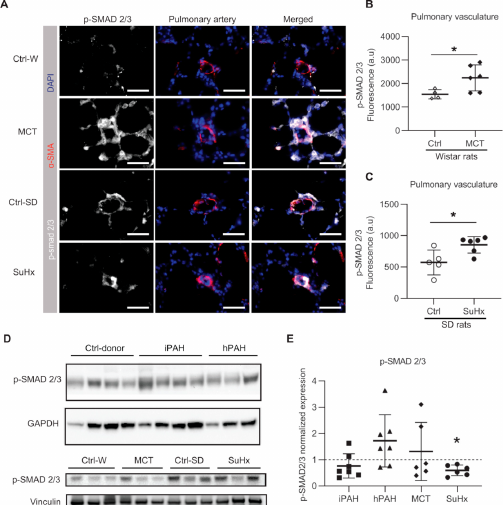
Figure 5. The phosphorylation of SMAD2/3 in human PAH and animal models of PAH: ( A ) repre- sentative immunofluorescent images; white = pSMAD2/3; red = α -SMA; blue = nuclei. Scale bar = 50 µ m; ( B ) quantified data of pSMAD2/3 expression within the area co-stained with α -SMA in MCT rats. Wistar rats: n(ctrl) = 4, n(MCT) = 6; ( C ) quantified data of pSMAD2/3 expression within the area co-stained with α -SMA in SuHx rats. SD rats: n(ctrl) = 5, n(SuHx) = 6; ( D ) representative images of Western blot analysis in whole lung lysates. ( E ) The quantification data of phospho-SMAD (pSMAD) 2/3 expression normalized to vinculin. n(iPAH) = 7, n(hPAH) = 7, n(MCT) = 6, n(SuHx) = 6. iPAH: idiopathic pulmonary arterial hypertension, hPAH: hereditary pulmonary arterial hypertension, Ctrl: control, MCT: monocrotaline rats, SuHx: sugen–hypoxia rats. * p <